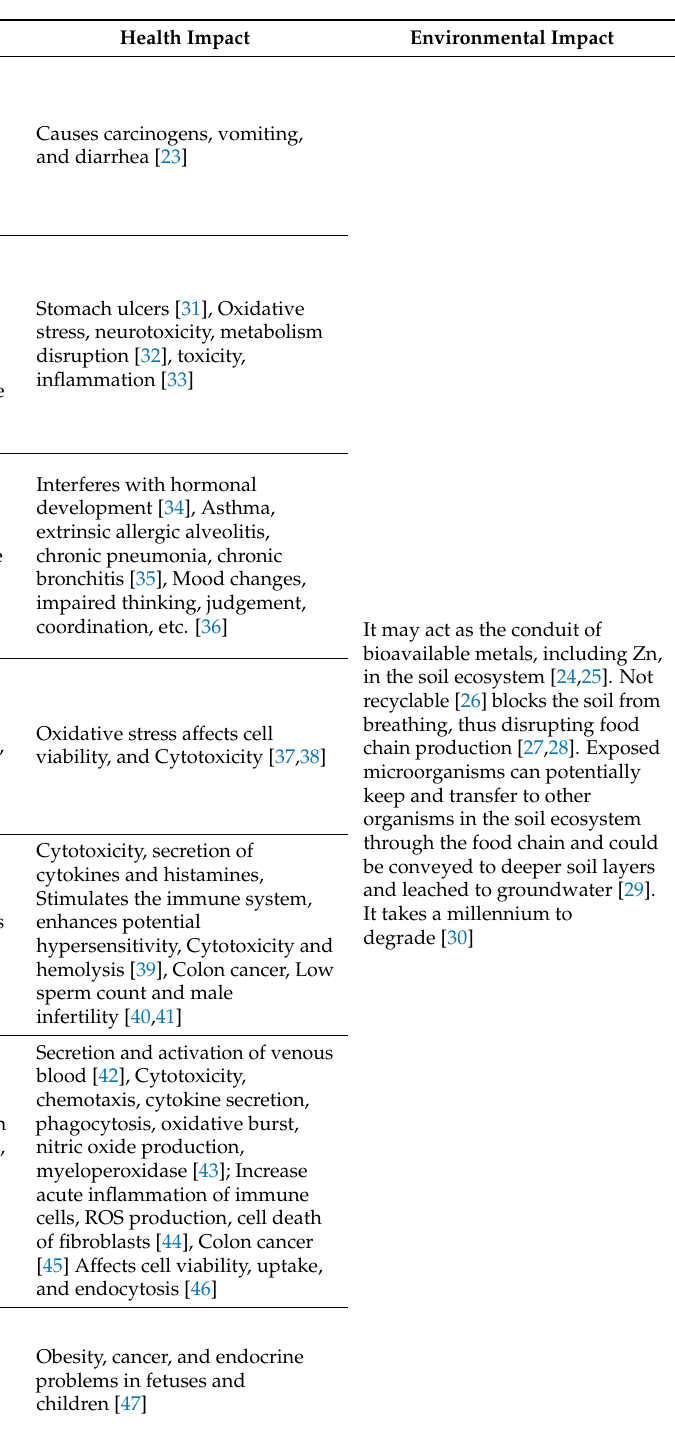
Table 1. Types, properties, and common uses of plastic and the impact of its